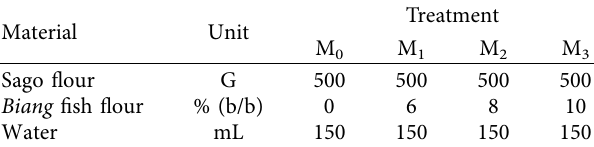
Table 1: The formula for making sago